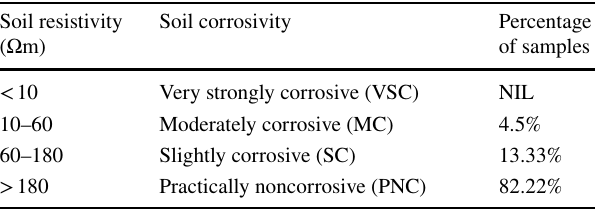
Table 3 Soil corrosivity ratings (Agunloye 1984; Oladapo et al. 2004; Mosuro et at. 2017)